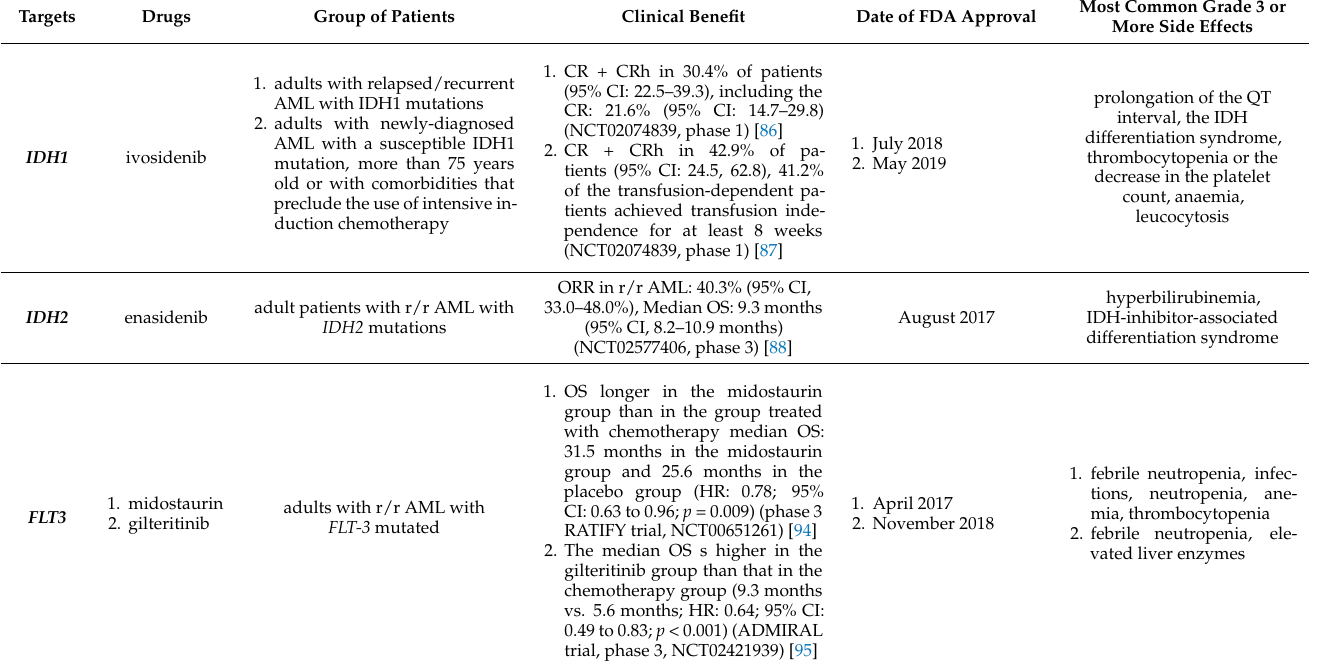
Table 2. Selected targeted approaches in the treatment of AML including Secondary acute myeloid leukemia (AML) [86–88,94,95,99,101]. CR + CRh—complete remission/complete remis- sion with partial hematologic recovery, ORR: overall response rate, r/r -relapsed/recurrent AML, OS—overall